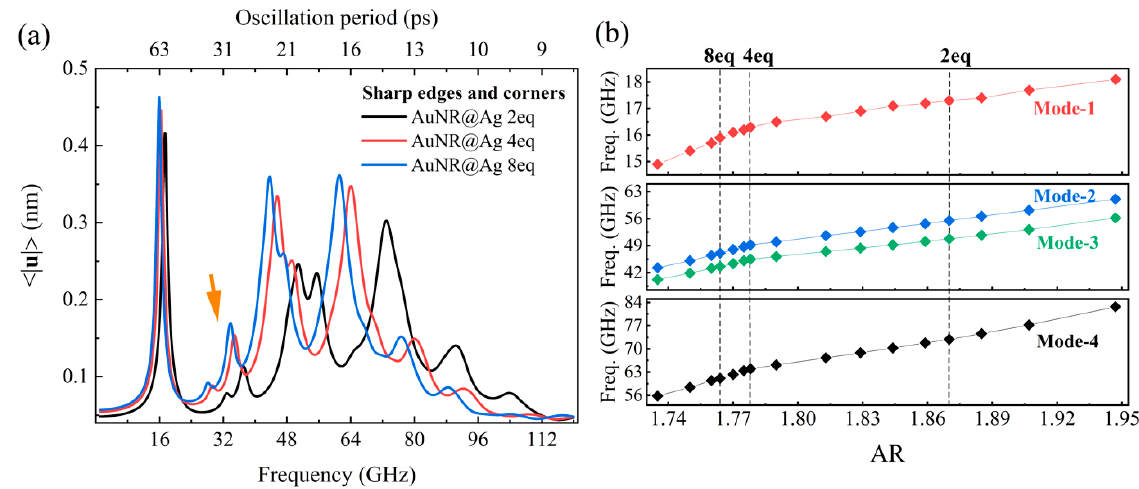
Figure 5. ( a ) Ag thickness dependent vibrational mode spectra for the AuNR@Ag 2eq, 4eq and 8eq samples calculated using their morphological parameters obtained from the TEM analysis. ( b ) The calculated mode frequency as a function of aspect ratio (AR), top panel for mode 1, middle panel for modes 2 and 3, and bottom panel for mode 4. The vertical dashed lines in ( b ) indicate the mode frequencies calculated for the AuNR@Ag 2eq, 4eq and 8eq samples using their morphological parameters obtained from the TEM analysis. The orange arrow points to a minor intermediate mode.